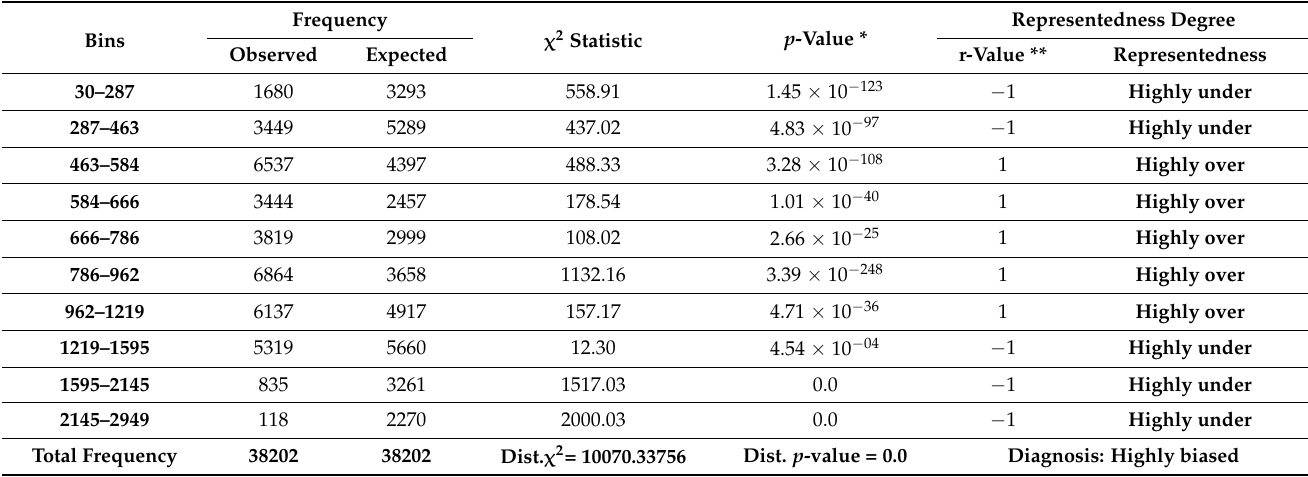
Table 6. Pearson’s χ 2 test results with average annual precipitation (mm/year)